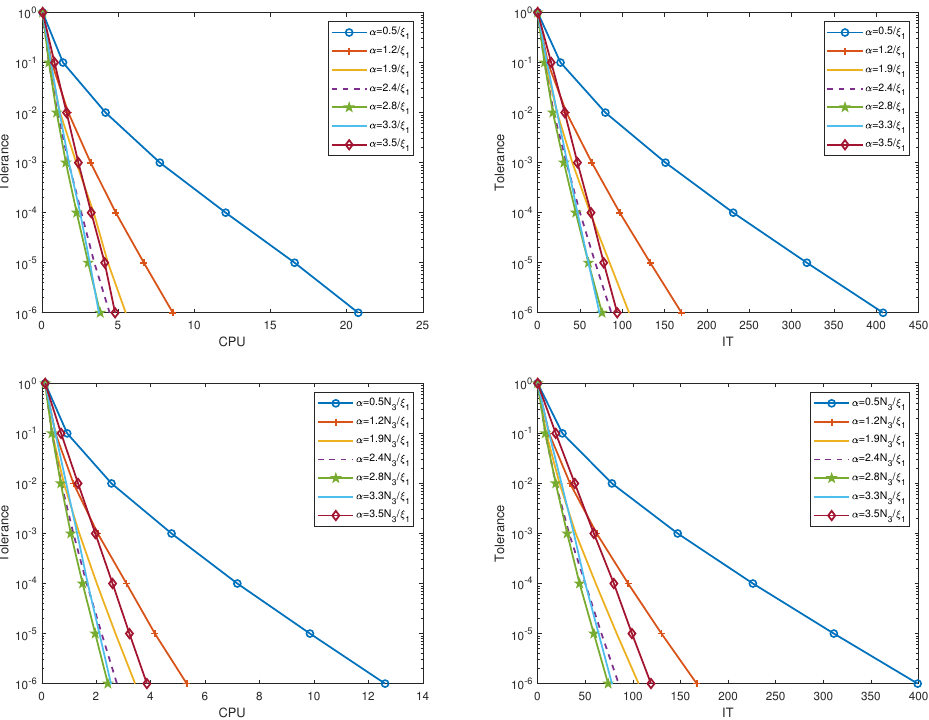
Figure 2. CPU and IT of the TRAKS and TRAKS F algorithms with β = 100 and different stepsizes α for different tolerances. Upper : TRAKS. Lower : TRAKS F .